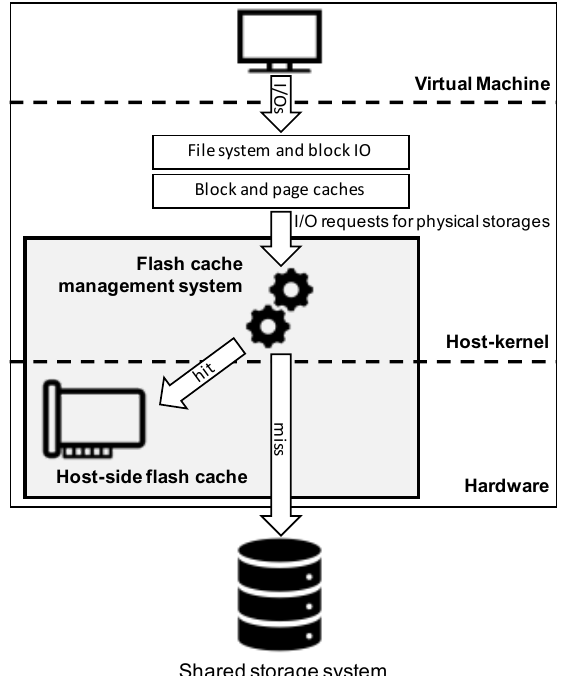
Figure 1. Linux System with